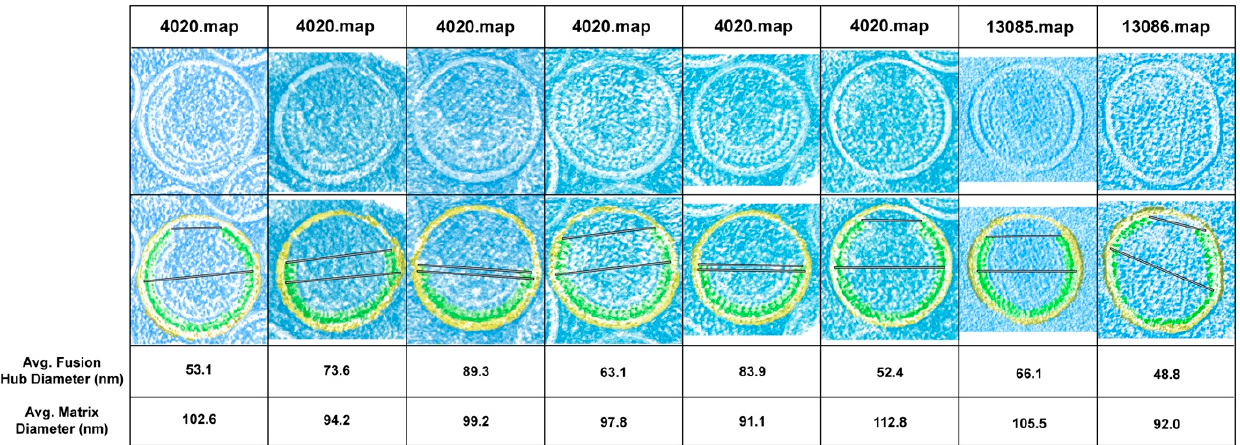
Figure 2. Cryo ‐ EM HIV ‐ 1 particles with measurements for the diameter and gap of the matrix (MA) shell. Top row represents raw data and the corresponding map number. Second row shows areas highlighted in green that represent the HIV ‐ 1 MA shell. Blue areas represent the remaining HIV ‐ 1 particle components and background signal. Yellow areas represent the lipid layer. Particles are overlaid with measurements of the HIV ‐ 1 MA shell diameter and gap.